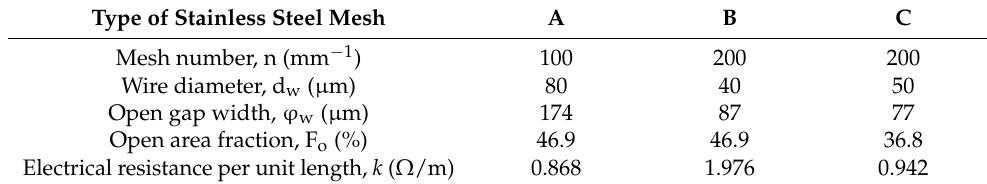
Table 1. Properties of stainless steel meshes.